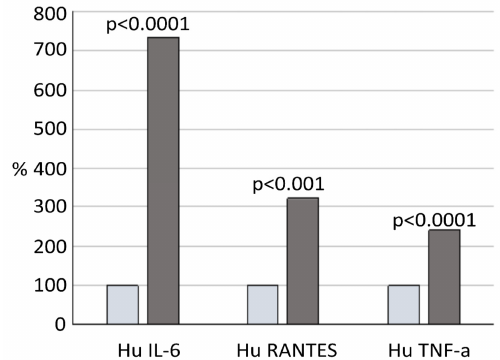
Figure 5. Graphical presentation of relative differences in proinflammatory cytokine values after total body irradiation between the patients with total amylase values below and above 374 U/L. Light-blue column shows values of low TA level group. Grey column shows values of the high TA level group. Abbreviations: Hu IL-6—human interleukin 6, Hu RANTES—human regulated upon activation normal T cell expressed and secreted cytokine, Hu TNF- α —human tumor necrosis factor α , TA—total